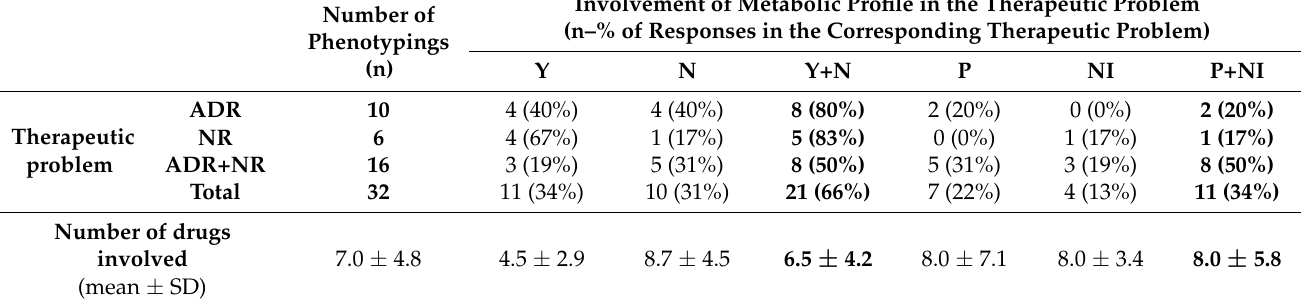
Table 3. Interpretation of the phenotypic assessment, in terms of the involvement of the metabolic profile in the therapeutic problem, depending on the context of the demand and the number of drugs implicated. Involvement of Metabolic Profile in the Therapeutic Number of (n)